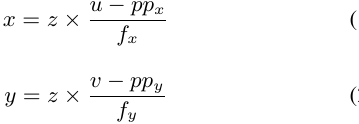
Figure 1. Low-cost Intel ® RealSense™ cameras: (a) D415 (b) SR305 (c) L515.